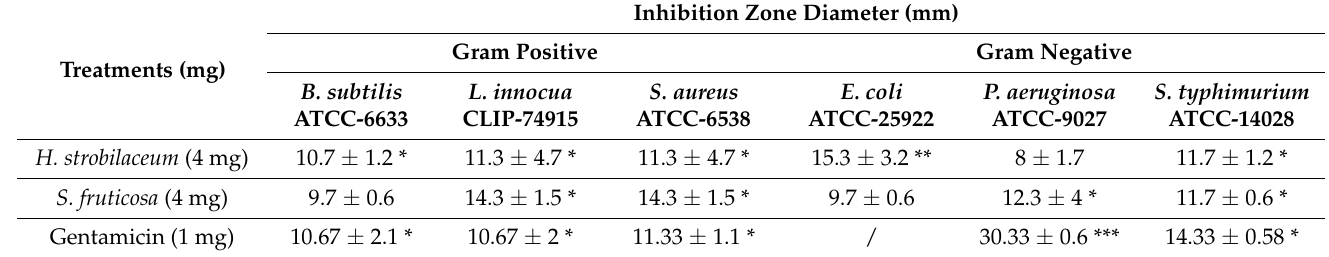
Table 7. Screening antibacterial activity of the H. strobilaceum and S. fruticosa hydro-methanolic